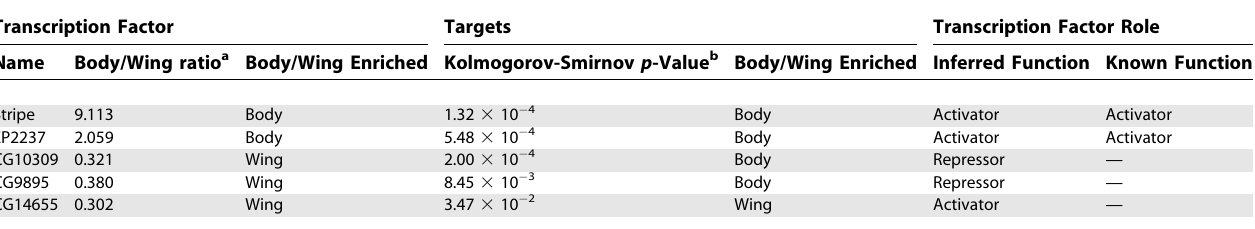
Table 1. Analysis of Differential Expression in D. melanogaster Imaginal Wing Disc Transcription